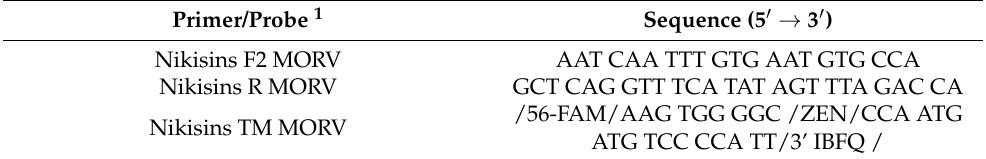
Table A1. PCR primer and probe sequences.